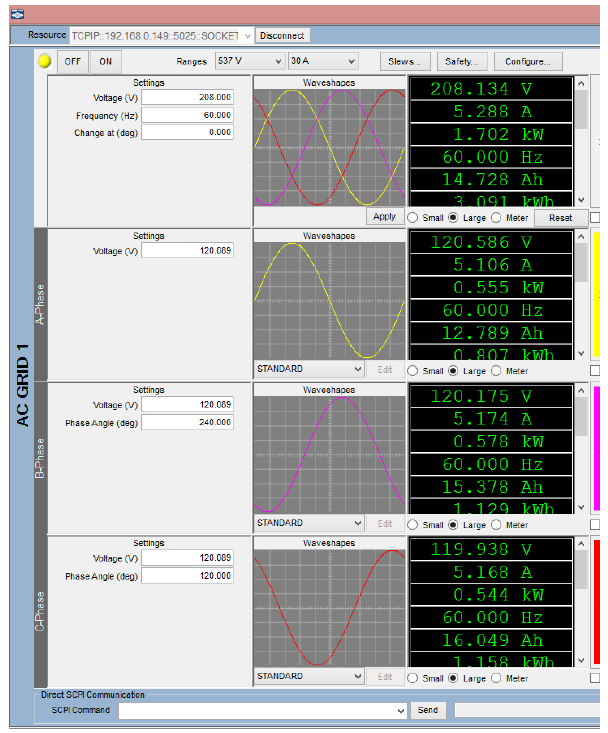
Figure 30. Hardware results using grid simulator NHR 9400 panel for real power = − 1.5 kW and reactive power = 0.5 kvar under unbalanced grid